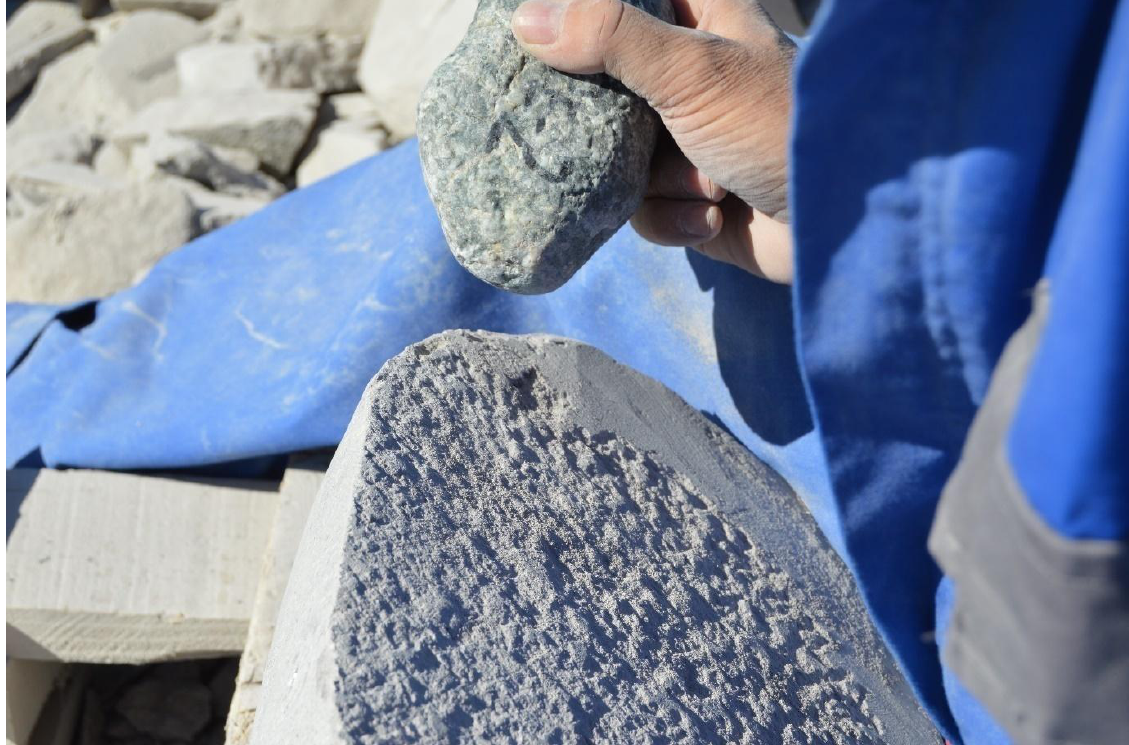
Figure 6. Μanufacture of experimental grinding tools: pecking of the use -surface (ERC